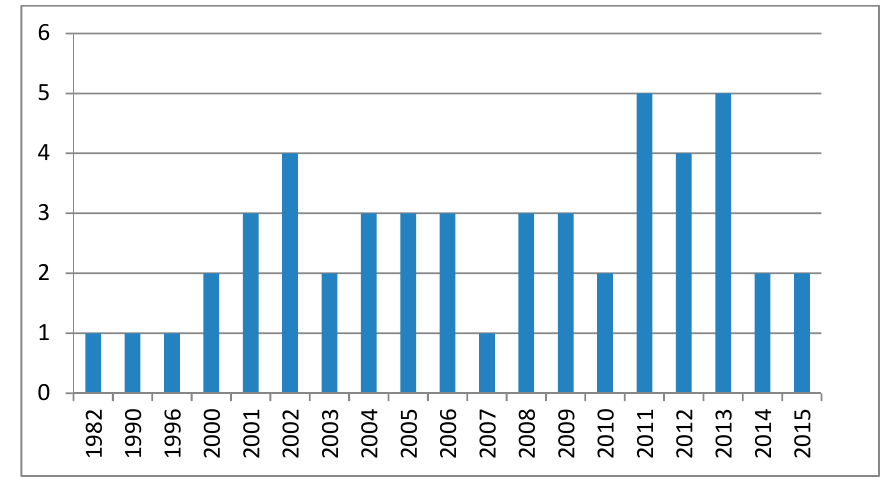
Figure 3. Number of papers per year.